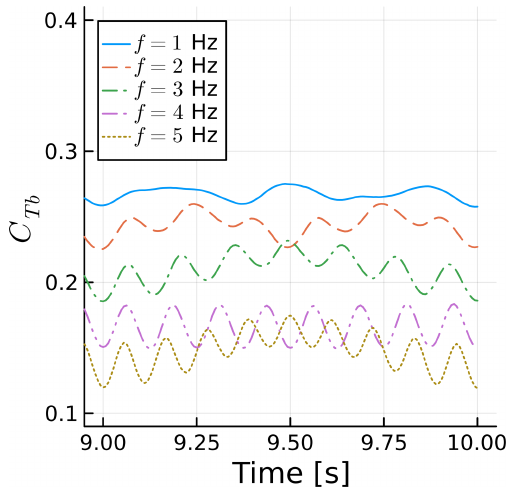
Figure 14. Time history of blade 1 thrust coefficient for various sway frequencies. Thrust normalized with maximum rotor velocity